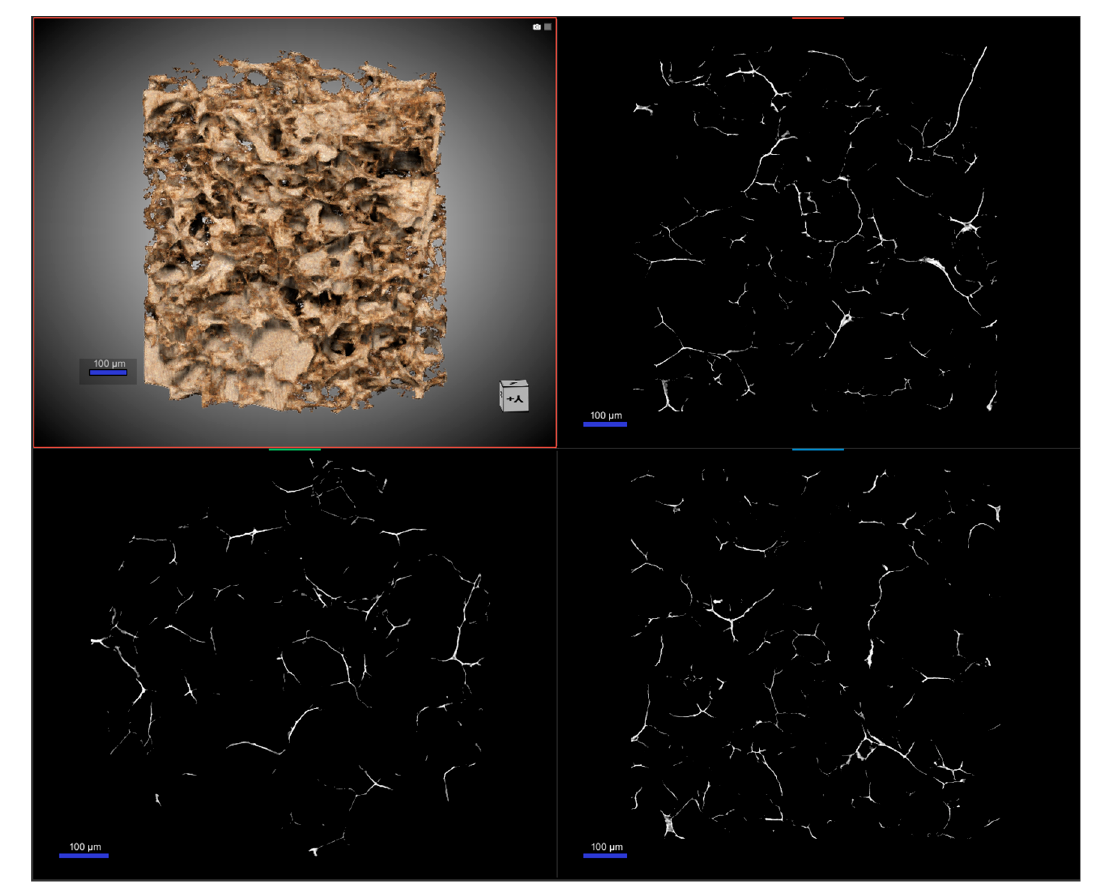
Figure 2. Nano-CT images of the GO-CS aerogel. On the top left, the 3D reconstruction of the gel is reported, and in the other panels, the reconstruction, as a 2D map, of the internal porosity paths from different angles is visible.